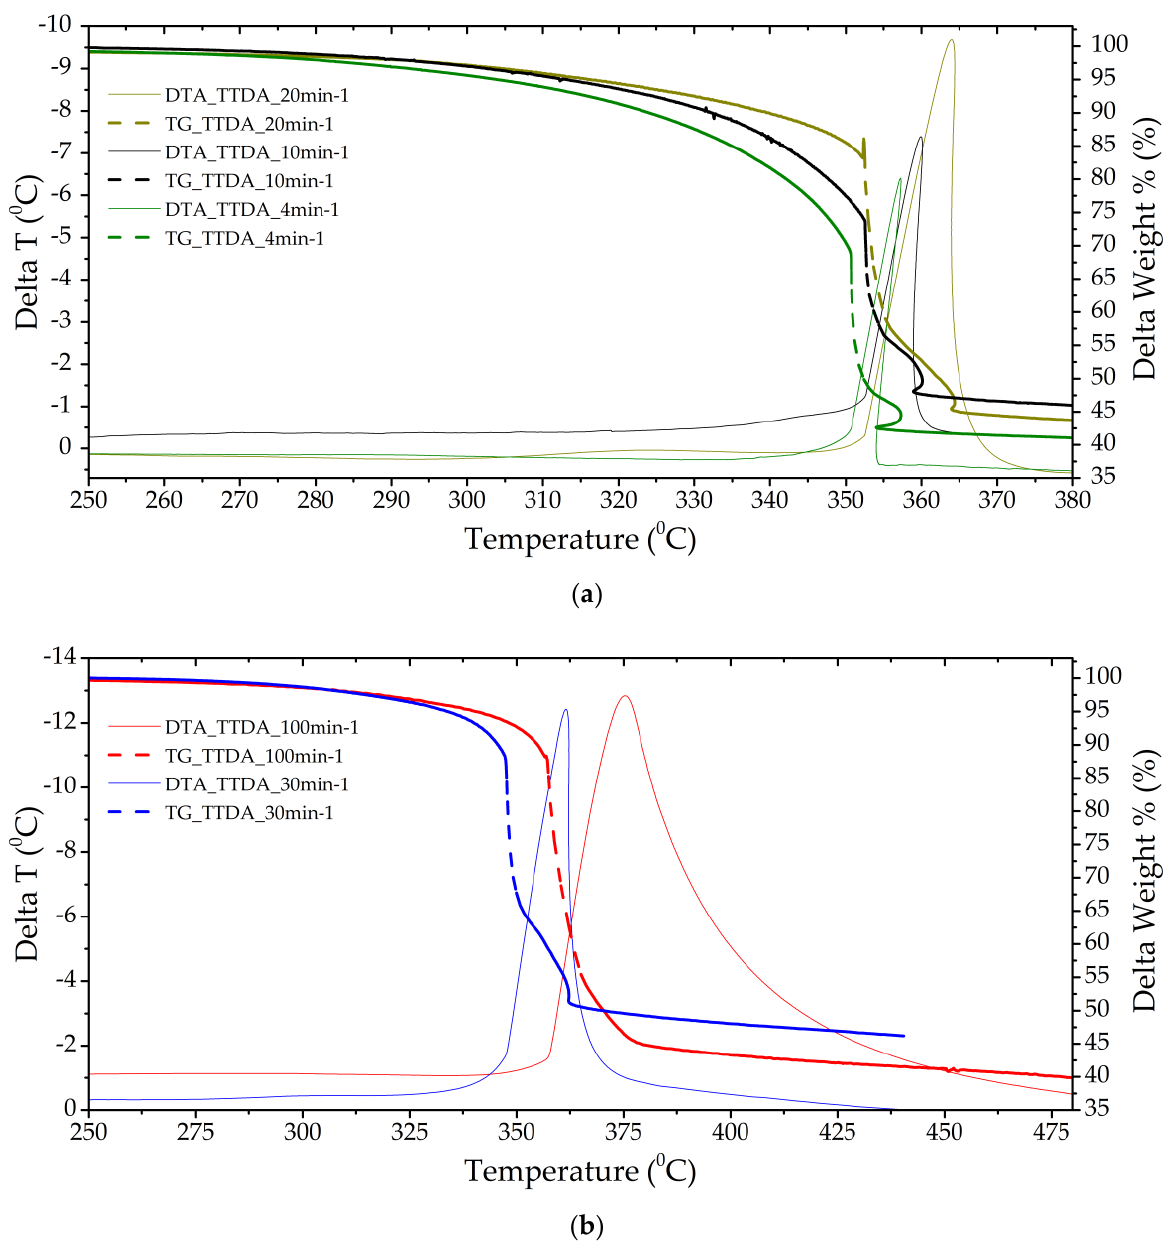
Figure 3. Thermograms of a TTDA sample with a separate stage of gas-phase decomposition ( a ) (heating rates of 4 and 10 min −1 ) and solid-phase decomposition with gas-phase assistance ( b ) (heating rates of 30 and 100 min −1 ).